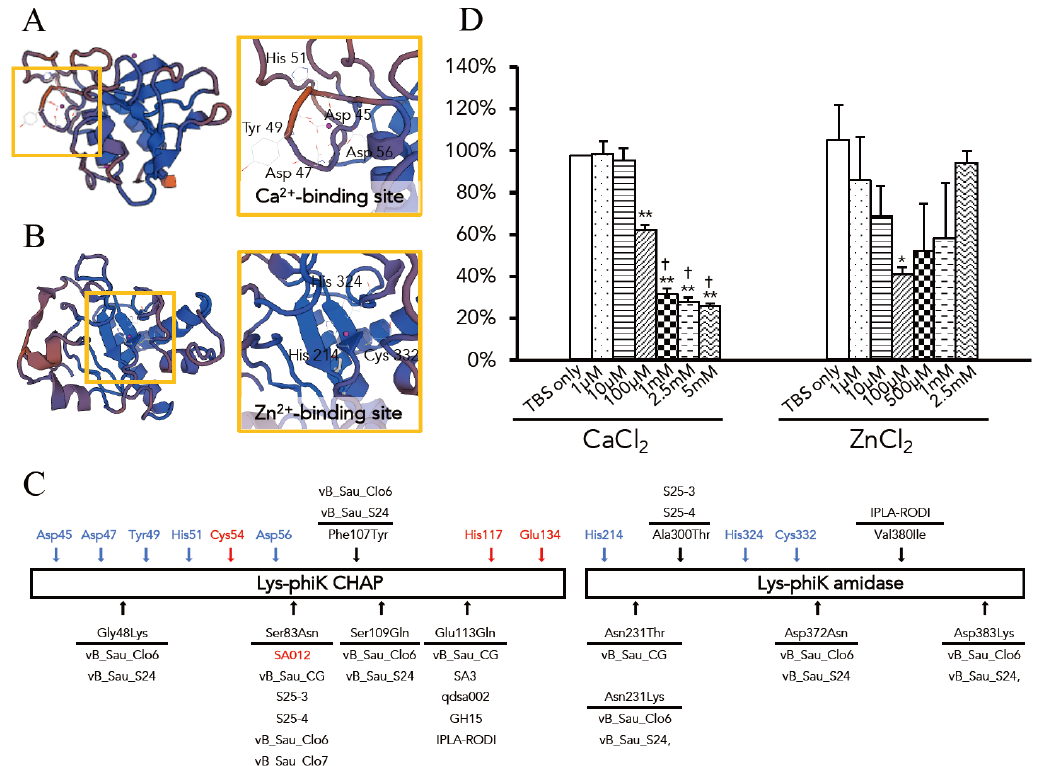
Figure 4. Protein structure modeling of the CHAP and AMID domains, and the effects of Ca 2+ and Zn 2+ on the lytic activity of Lys-phiSA012. Protein structure models of ( A ) the CHAP and ( B ) AMID domains in Lys-phiSA012. The models were constructed using the SWISS-MODEL server and the homologous proteins used for protein structure modeling are summarized in Table 3. Detailed views of the Ca 2+ and Zn 2+ coordination sites are framed in yellow. The Ca 2+ -binding site is composed of Asp45, Asp47, Tyr49, His51 and Asp56. The Zn 2+ -binding site is composed of His214, His324 and Cys332. Ions are shown as pink spheres. ( C ) Schematic image of the CHAP and AMID domain of Lys-phiK. Blue arrows indicate the amino acid residues which contacts with Ca 2+ and Zn 2+ . Red arrows indicate the active site residues of the CHAP domain. Black arrows indicate the amino acid changes in LysK-like endolysins summarized in Table 4. Bacteriophages whose endolysins are related to Lys-phiK are also indicated. Lys-phiSA012 differs by single amino acid residue from Lys-phiK, Ser83Asn on a CHAP domain. ( D ) The effects of Ca 2+ and Zn 2 on the lytic activity of Lys-phiSA012 were analyzed using a turbidity reduction assay as described in the materials and methods section. Data are shown as relative OD 600 reduction rate (initial OD600 divided by OD600 60 min after adding Lys-phiSA012). The values represent means ± SD. Significance was analyzed by the Tukey-Kramer test based on one-way ANOVA and is indicated by asterisks compared to TBS alone (*: p < 0.05, **: p < 0.01) or crosses against 100 µ M Ca 2+ ( † : p <